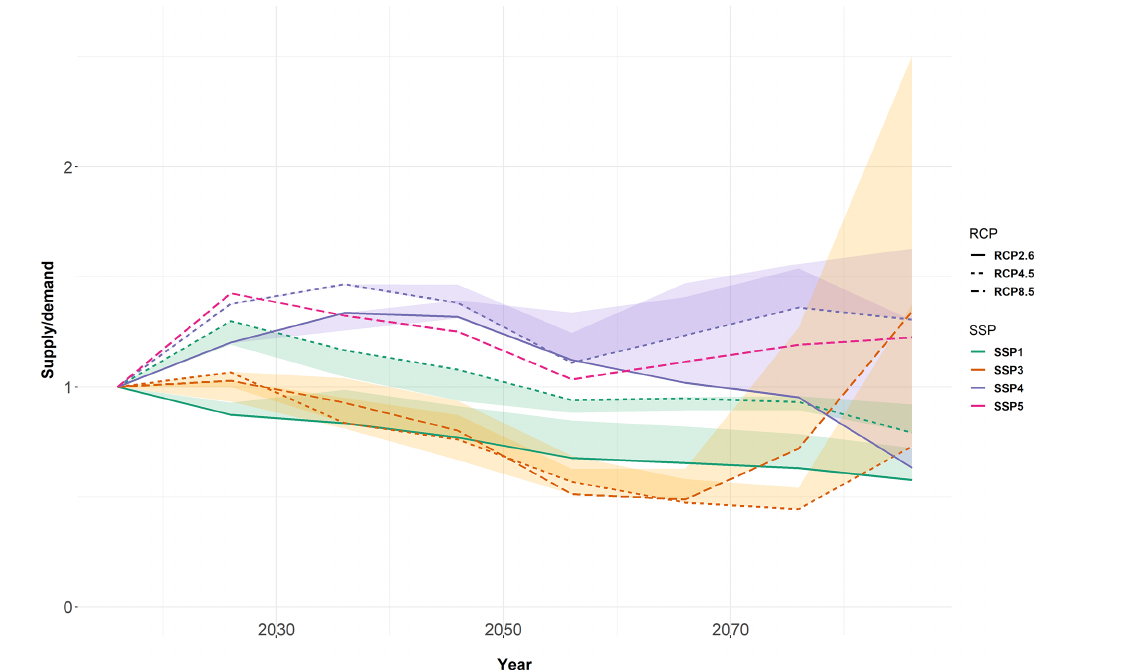
Figure 2. Food (meat and crops) supply as a proportion of demand in all simulated scenario combinations. Values less than 1 indicate a shortfall. Shaded areas show the ranges of results produced by simulated behavioural variations within each scenario, with the range in RCP8.5–SSP5 being too small to be visible. Absolute per capita demand levels (including non-food usage and waste of food crops) are approximately twice as large by 2080 in SSPs 1 and 5 as in SSPs 3 and